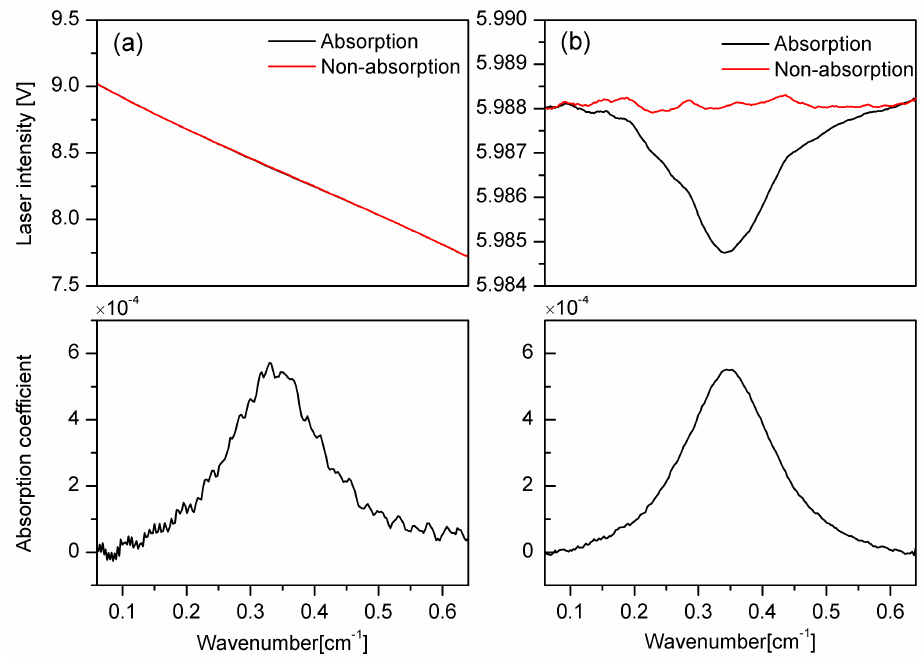
Figure 5. Upper windows: A comparison of the transmitted intensity without (panel a ) and with (panel b ) intensity stabilization. The red curves represent measurements from an empty gas cell while the black ones correspond to the case when 16 ppm of C 2 H 2 is in the cell. Lower windows: The corresponding absorption coefficients created by the use of Beer’s law and the data in the upper windows.